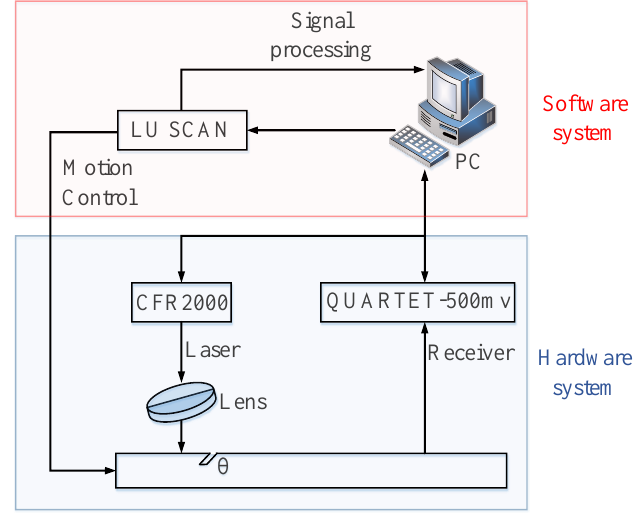
Figure 20. Schematic block diagram of the experimental platform.